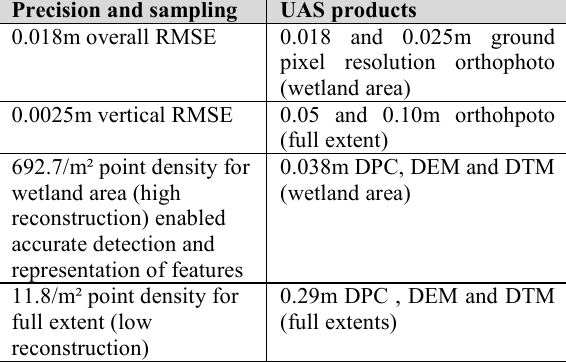
Table 2. Summary of the UAS products utilised.